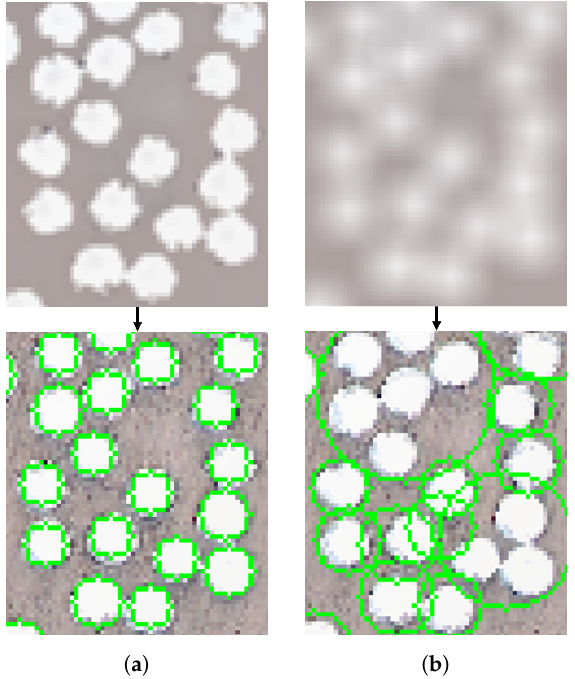
Figure 18. Optimal, K = 2 ( a ) versus extreme, K = 10 ( b ) blur results. To obtain a binary image, thresholding is applied to the blurred micrograph